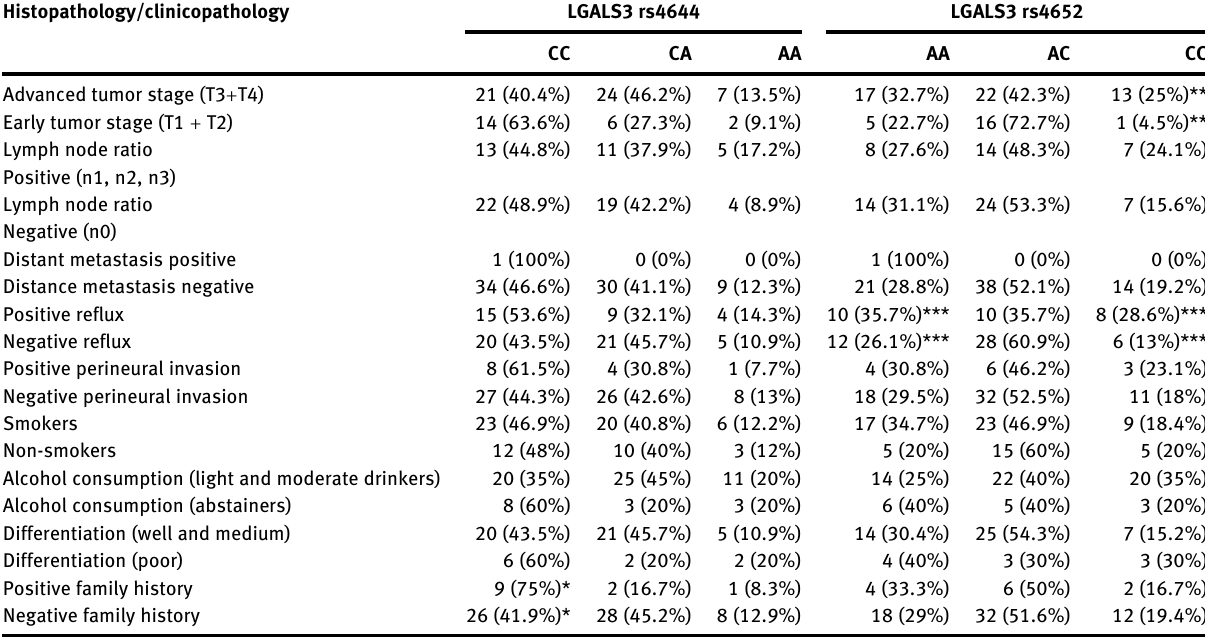
Table  : LGALS  genotype distribution according to histopathological and clinicopathological features in LSCC group.